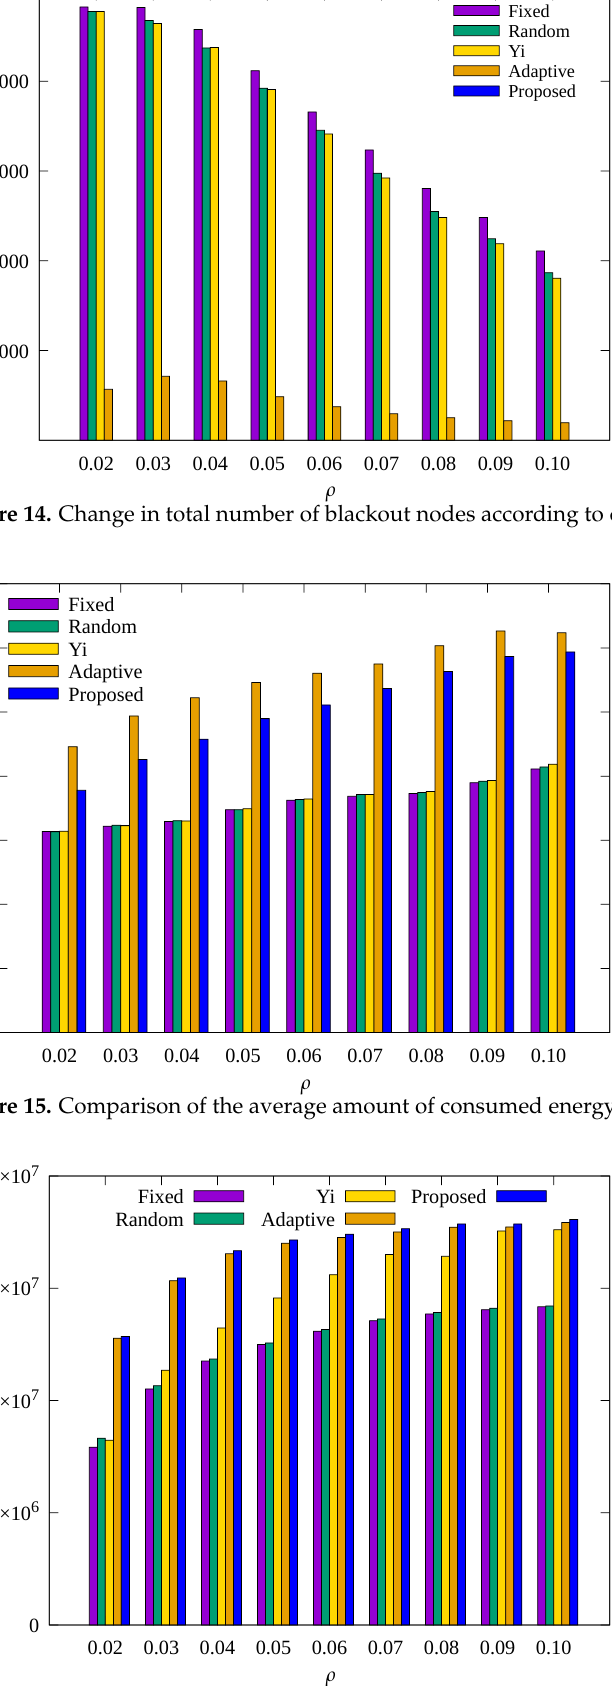
Figure 16. Comparison of the number of data gathered according to